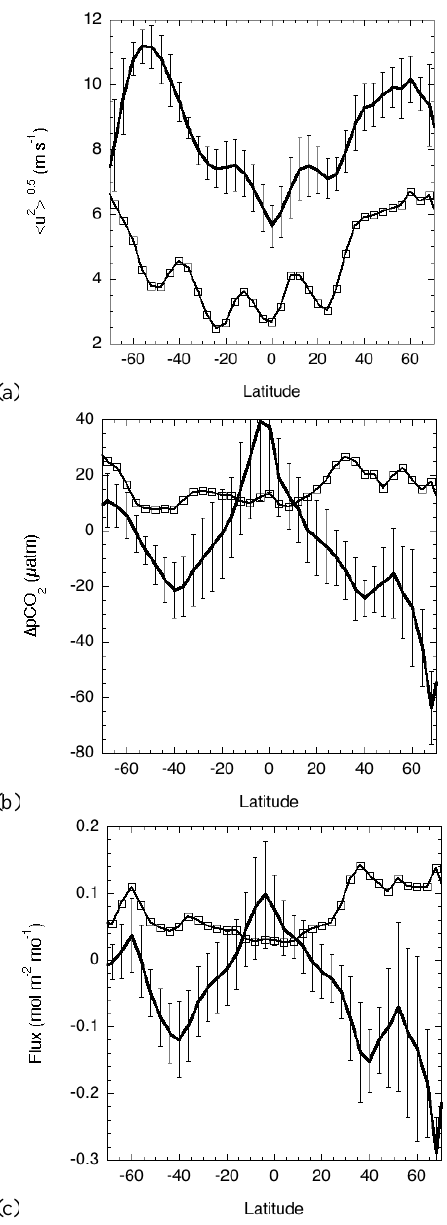
Fig. 9. Latitudinal distribution of zonal means (thick solid line) and standard deviations (spatial and temporal variability; thin solid line with squares) for the: (a) square root of the second moment <U 2 > 0 . 5 of the 20yr monthly mean CCMP wind product; (b) 1p CO 2 from the monthly Takahashi et al. (2009) climatology; and (c) the specific sea–air CO 2 flux [molm 2 month − 1 ] computed by applying the 20yr CCMP wind product to the Takahashi p CO 2 cli- matology using Eq. (2). The error bars on the zonal means indicate the spatial variability (standard deviation) of means for the 5 ◦ lon- gitude bins in the particular latitude